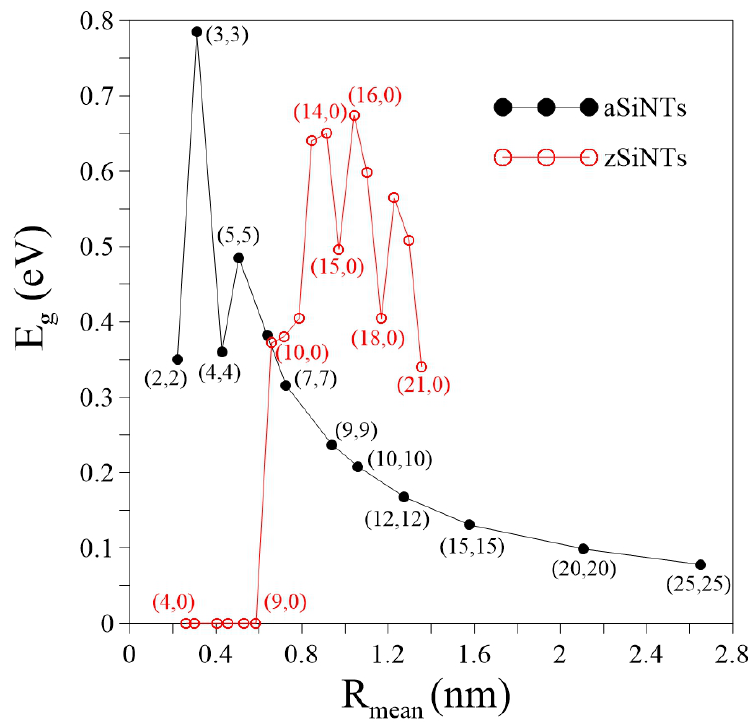
Figure 4. The dependence of band gap E g on the radius for aSiNTs (black curve) and zSiNTs (red